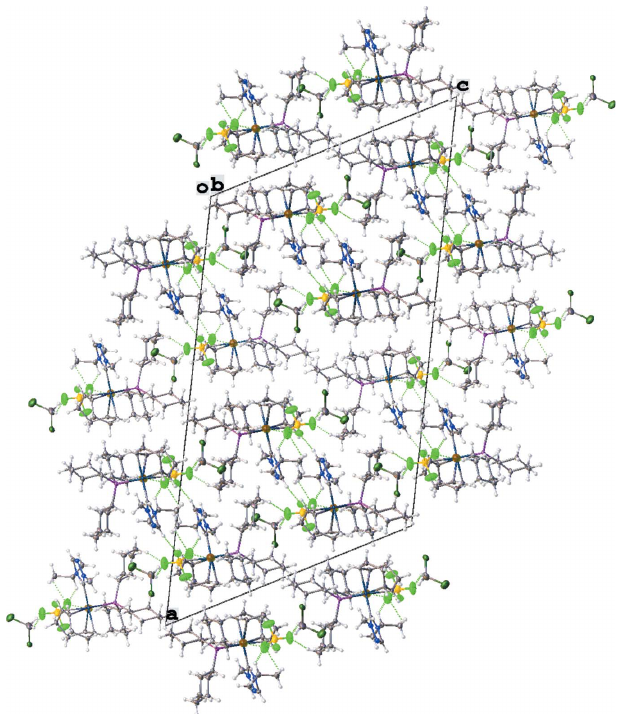
Figure 2 Crystal packing unit-cell diagram of the title compound ( 4 ) shown along the b axis. Non-classical hydrogen-bonding interactions between F and H atoms are shown as dotted green lines.